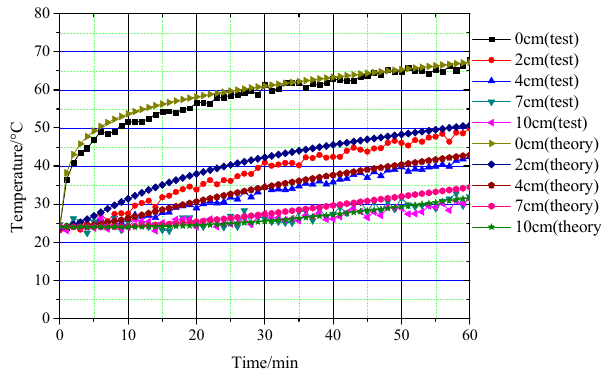
Figure 7. Results of theoretical calculation and tests of AC.